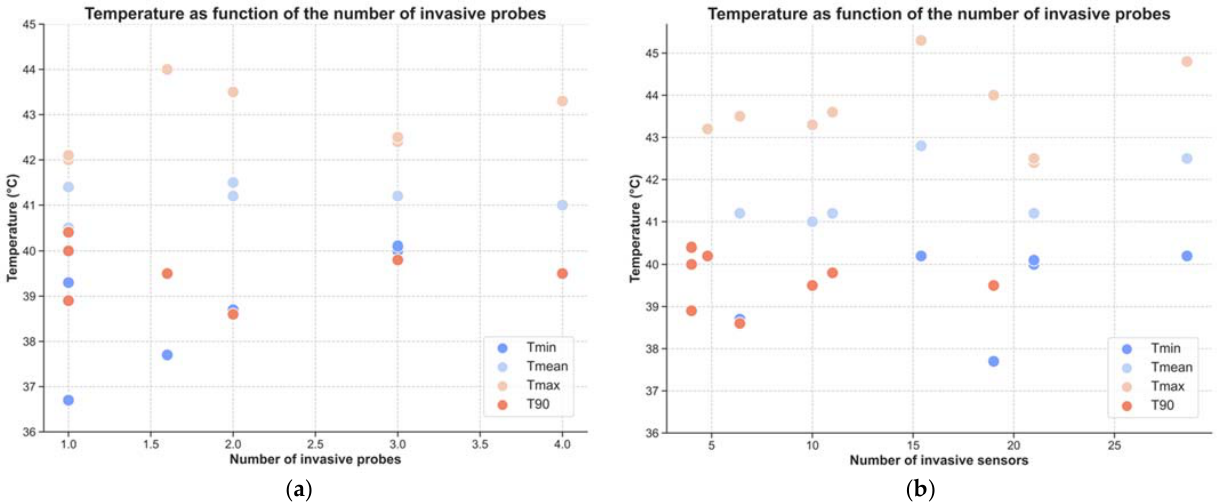
Figure 7. Temperature parameters as a function of the number of invasive probes ( a ) and invasive sensors ( b ).